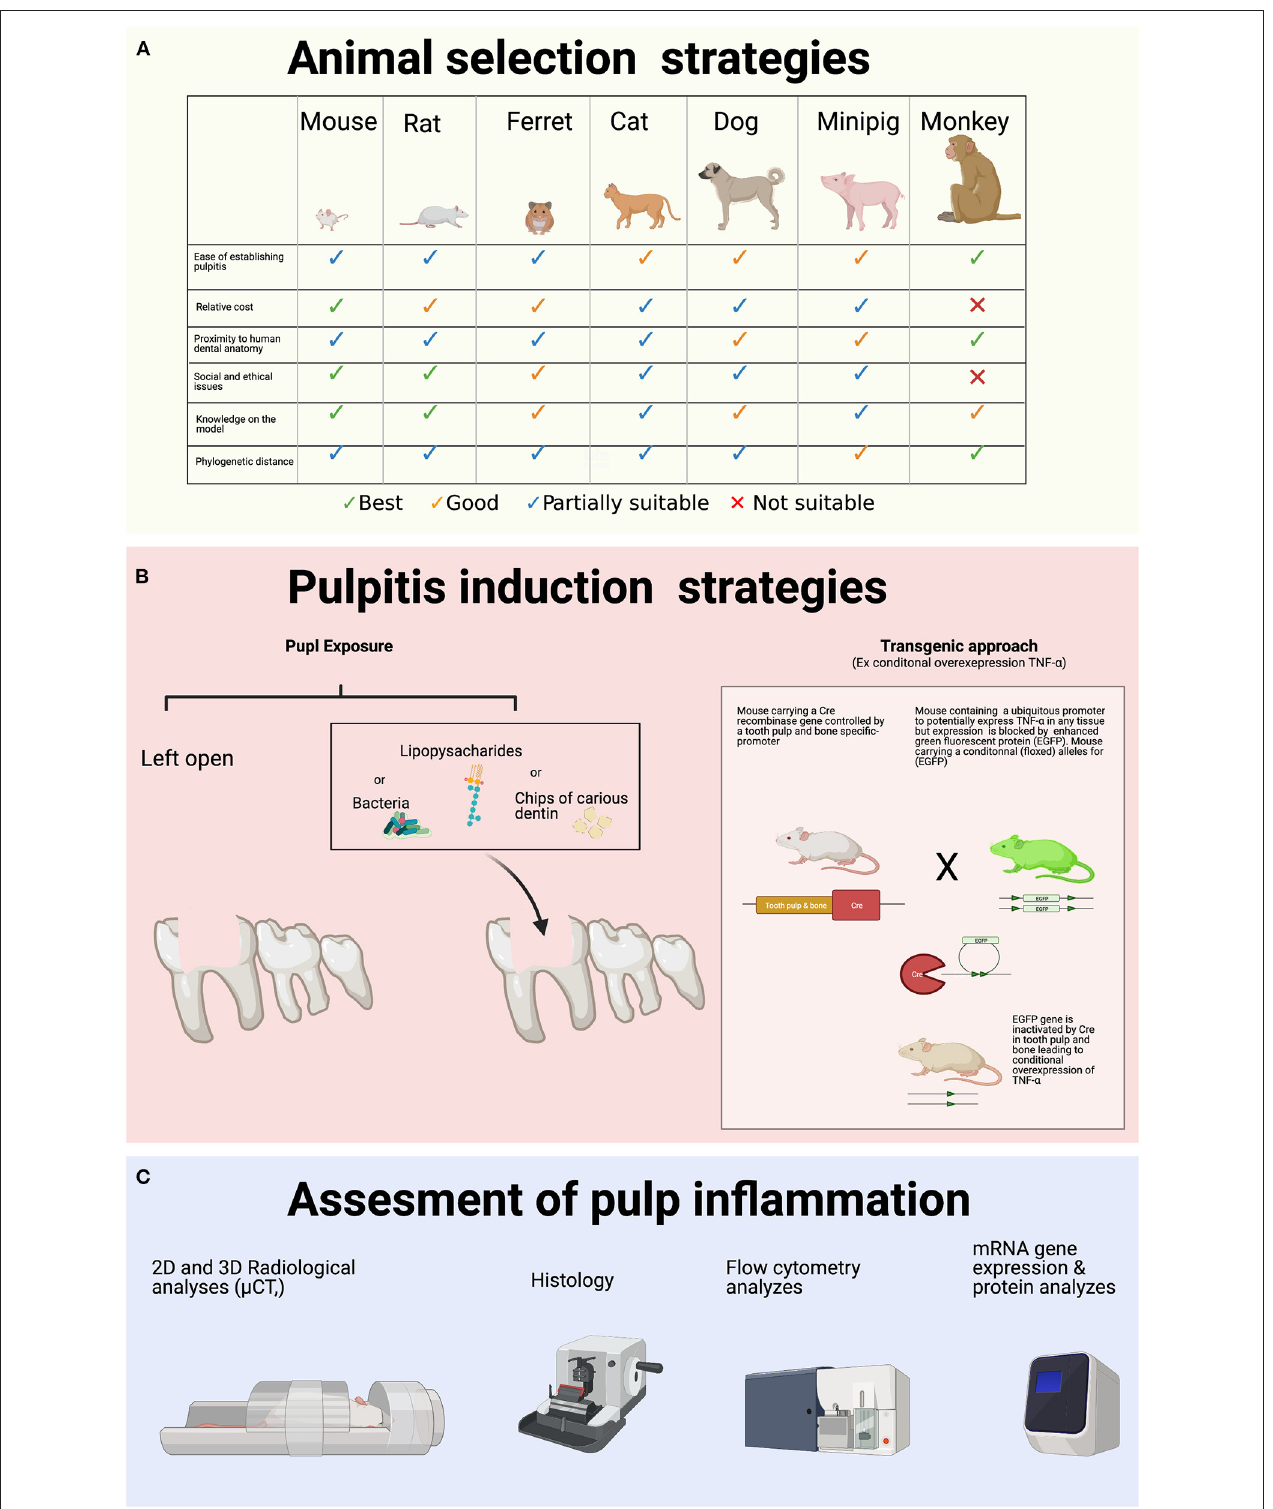
FIGURE 1 | Animal models to study pulp inflammation. (A) Criteria to define the optimal choice of the animal model to study pulp inflammation. (B) Different methods can be used to induce pulp inflammation. (C) Complementary methods to assess pulp inflammation in rat incisors. Figure was created with BioRender.com.